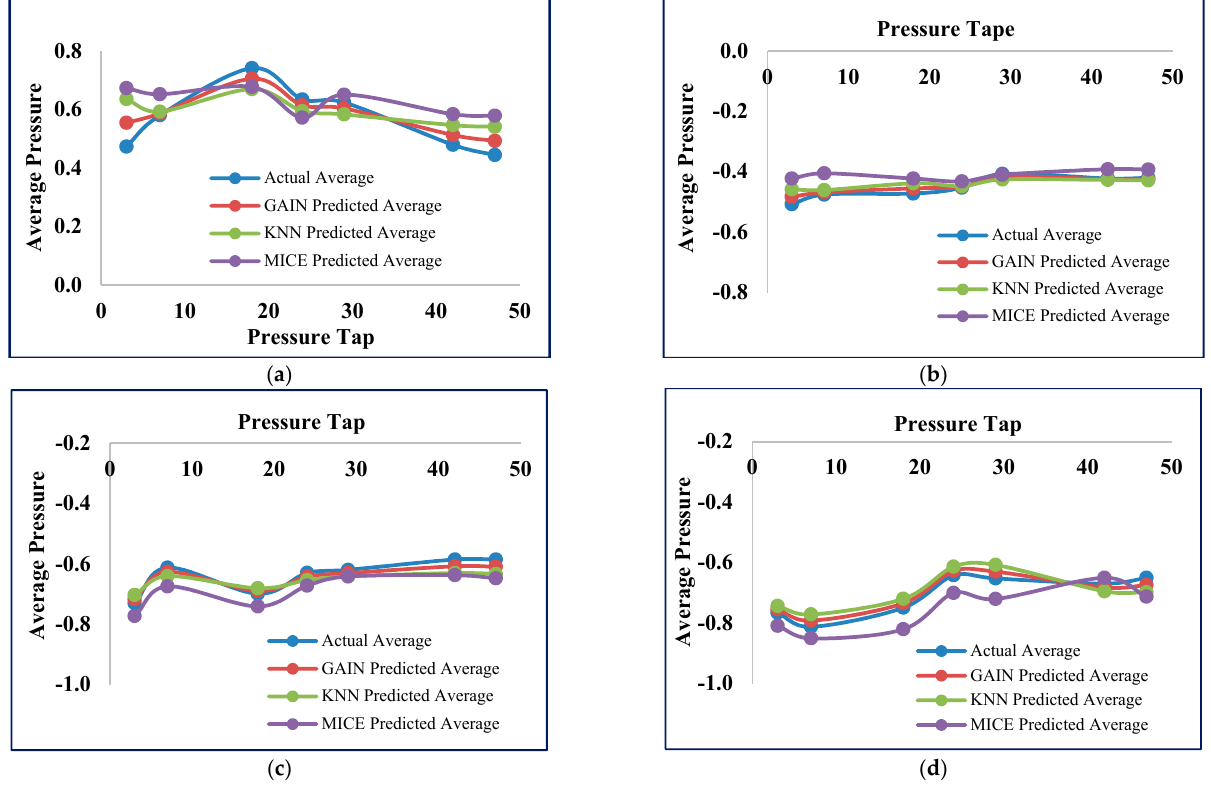
Figure 19. Average pressure value comparison on all sides. ( a ) Average pressure—front side; ( b ) Average pressure—back